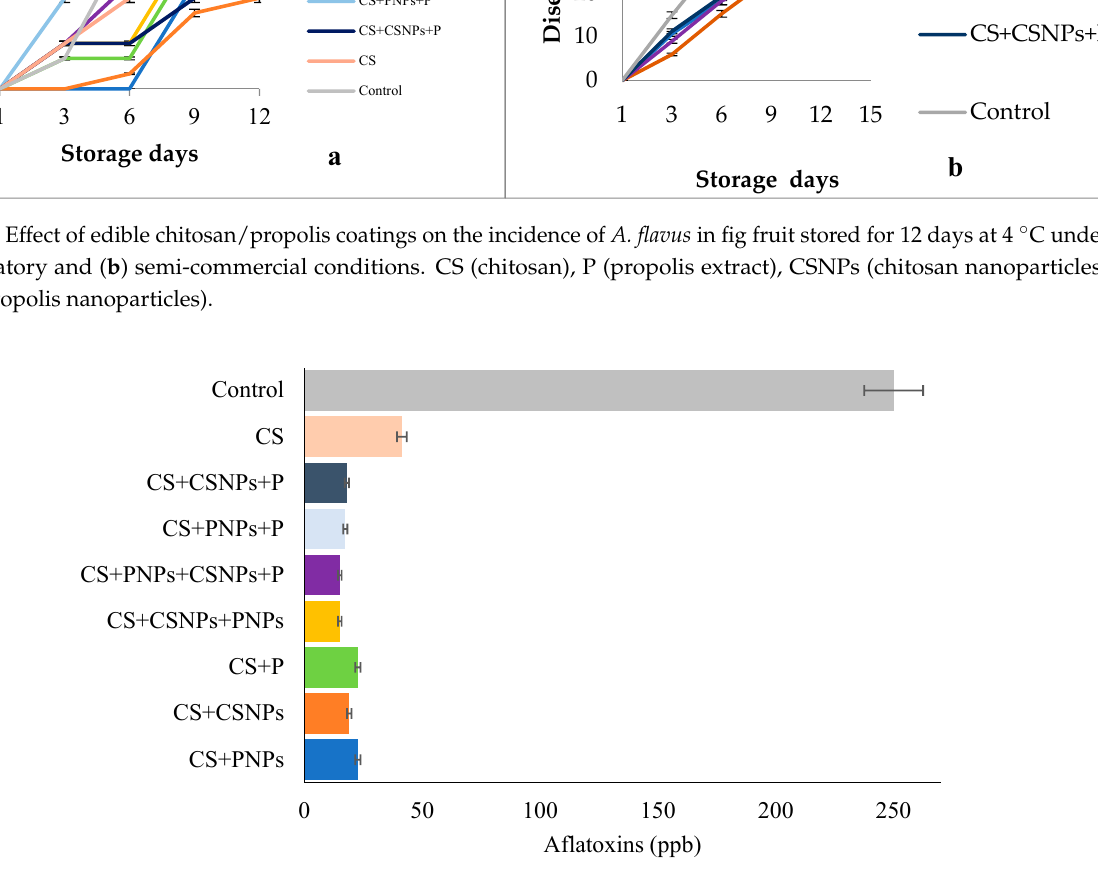
Figure 3. Effect of edible chitosan/propolis coatings on the incidence of A. flavus in fig fruit stored for 12 days at 4 °C under: ( a ) laboratory and ( b ) semi-commercial conditions. CS (chitosan), P (propolis extract), CSNPs (chitosan nanoparticles), PNPs (propolis nanoparticles).